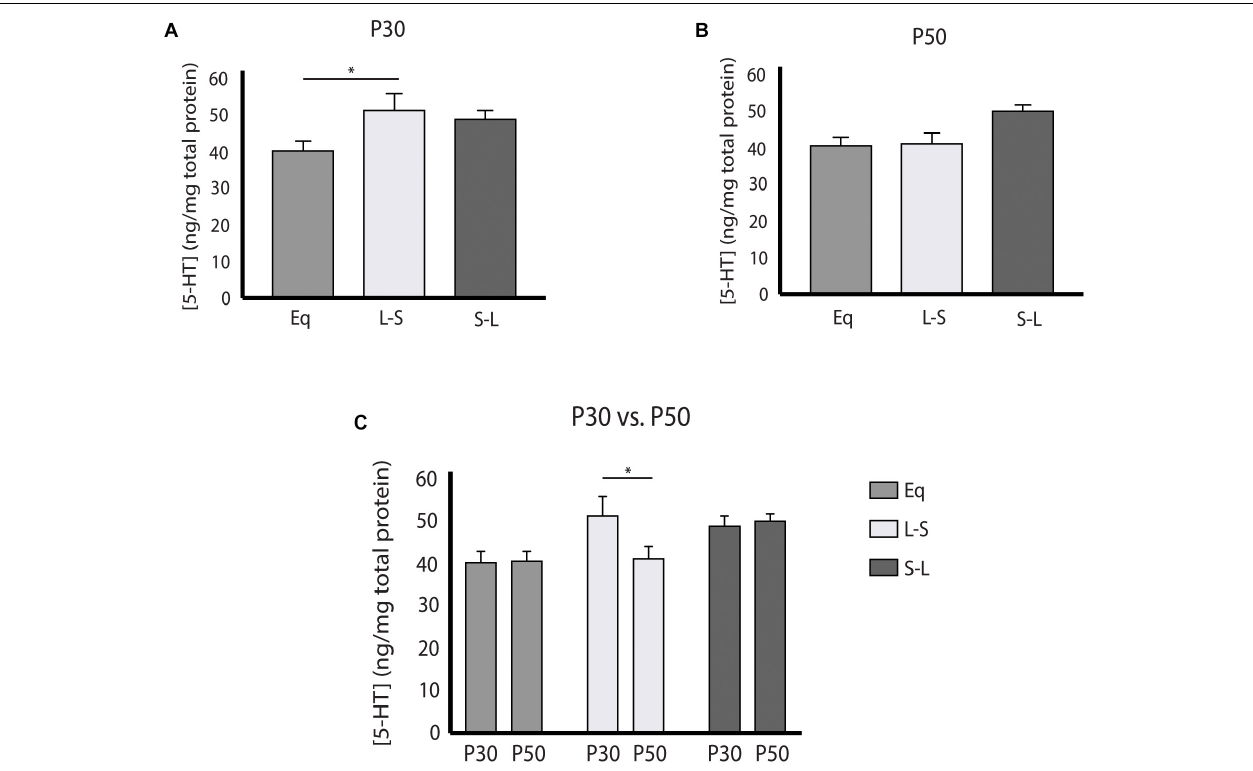
FIGURE 4 | Pre and Postnatal Long photoperiod exposures impact serotonin (5-HT) concentration during development. (A) Analysis of 5-HT content across photoperiods at P30, (B) at P50, and (C) within photoperiods during the P30 and P50 time points. The significance levels are as follows: ( ∗ p < 0.05) using Holm-Sidak’s multiple comparison tests. C) When evaluating 5-HT levels within photoperiod, significant differences were observed between the P30 and P50 time points for the L-S photoperiod ( p =